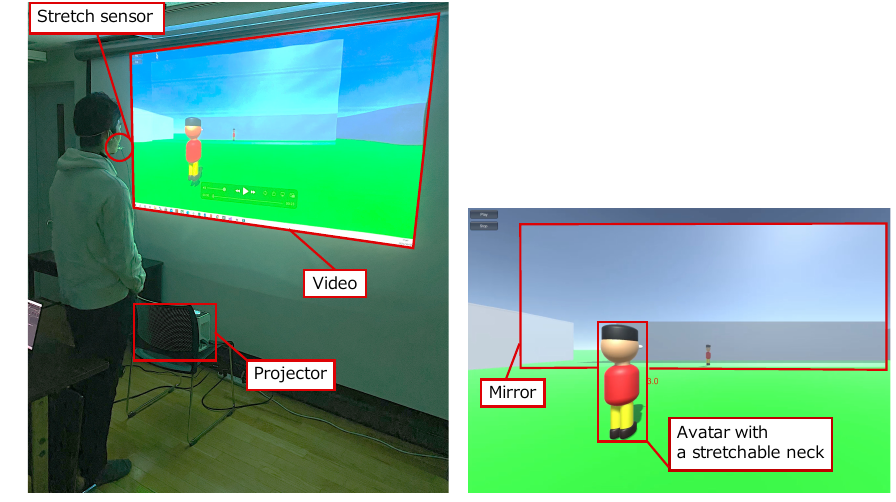
Figure 6. Experimental